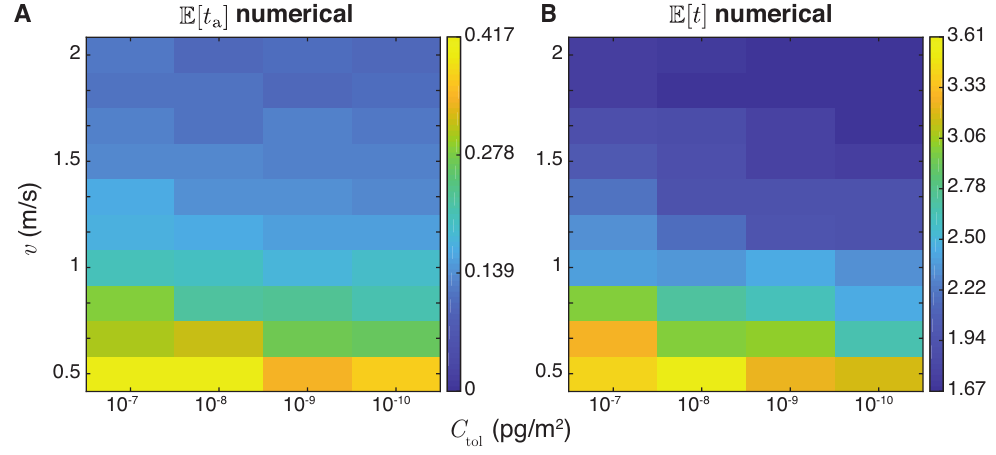
Figure 13. Simulation results from the agent-based Plume Navigation Model described in Section 5 for N = 10,000 moths attempting to reach a female calling for t call = 8 h via the continued release of m p = 1 pg per second. ( A ) Contour plot of mean first arrival time E [ t a ] of males in { C tol , v } phase space. ( B ) Contour plot of the mean arrival time of males in { C tol , v } phase space. Both mean first arrival times and mean arrival times are measured in